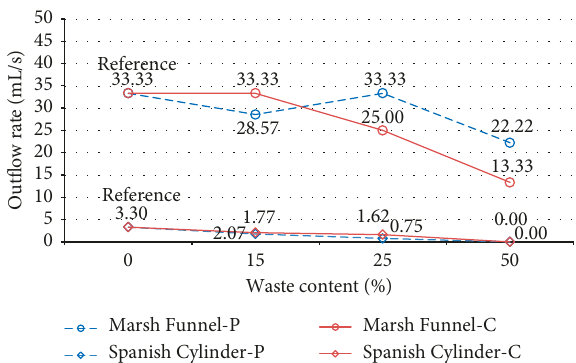
Figure 9: SLM outflow rate results. P: porcelain waste; C: ceramic waste.